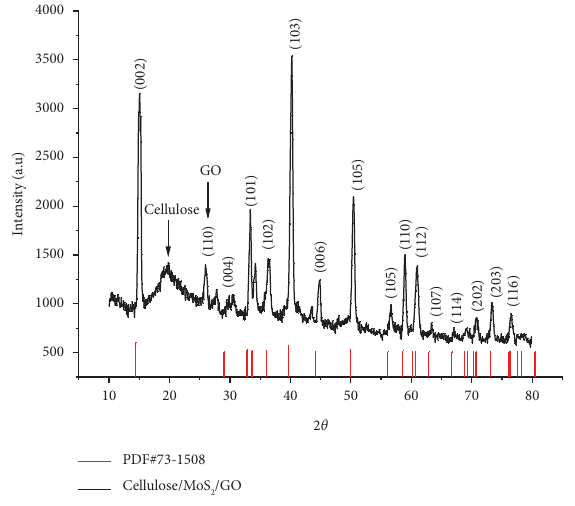
Figure 4: XRD studies of cellulose/MoS Table 1: XRD data of cellulose/MoS 2